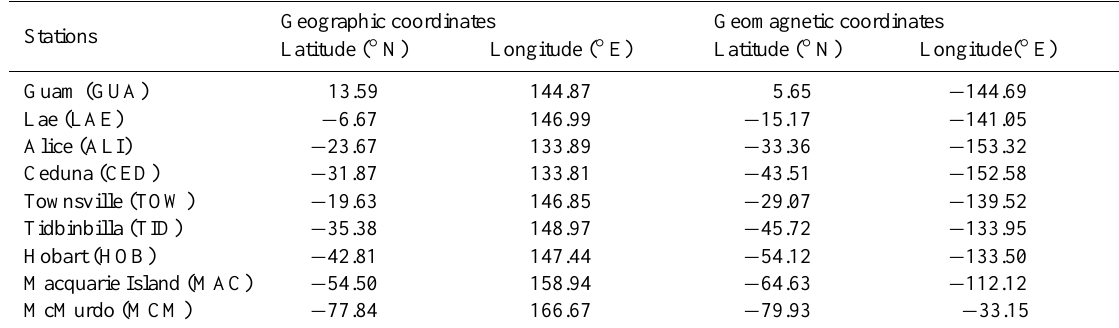
Table 1. Geographic and geomagnetic coordinates of the chain of IGS stations that provided data for this study. The three letters in bracket refer to the abbreviation of the station names.